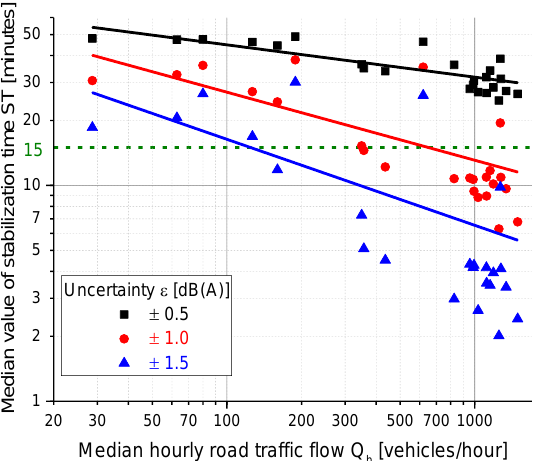
Figure 4. Median hourly ST values for the three preset uncertainty ε of the L Aeq,1h estimate versus median hourly road traffic flow Q h . The green dashed line corresponds to the measurement time t = 15 min, often used in common practice for road traffic noise measurement. Table 2. Percentage of ST values ≤ 15 min for each road type and uncertainty ε